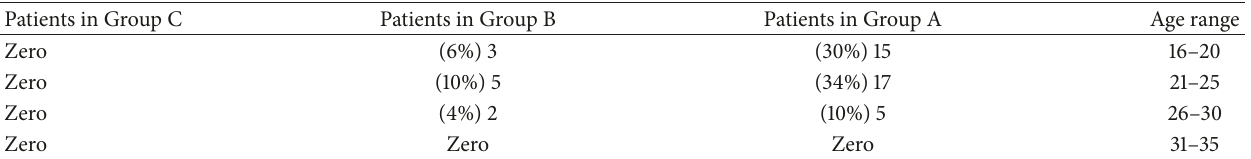
Table 3: The frequency of tonic-clonic seizure in patients treated with tramadol with symptoms of ankle clonus, according to their age, referred to Imam Reza (AS) Hospital in